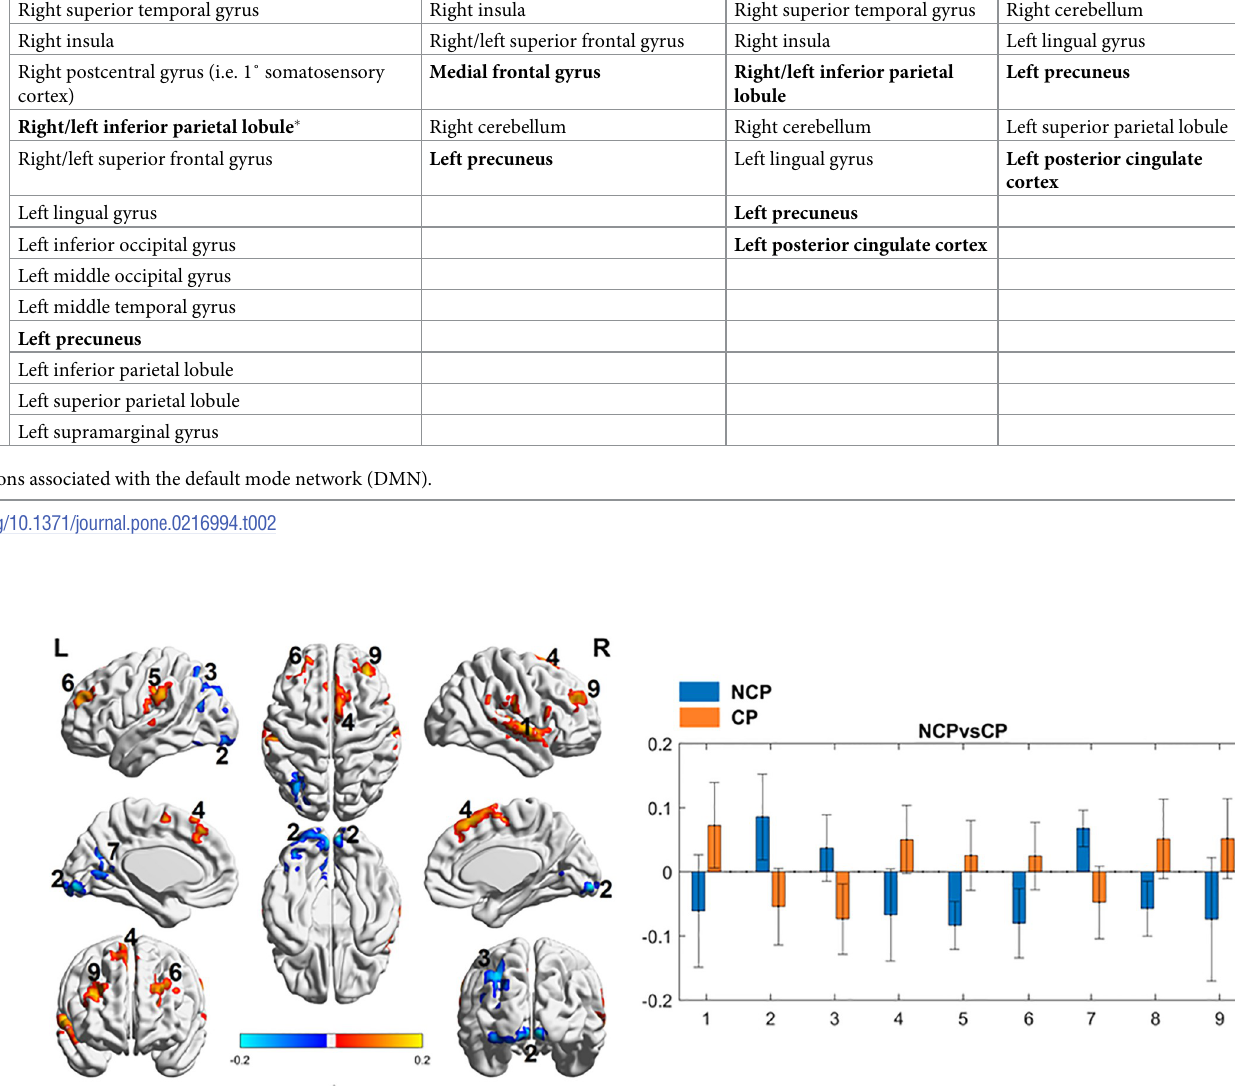
Table 2. Brain regions and their functions where differences in functional connectivity were observed between SCD adults with and without chronic pain. Function Sensory processing Right superior temporal gyrus Right insula Right postcentral gyrus (i.e. 1˚ somatosensory cortex)